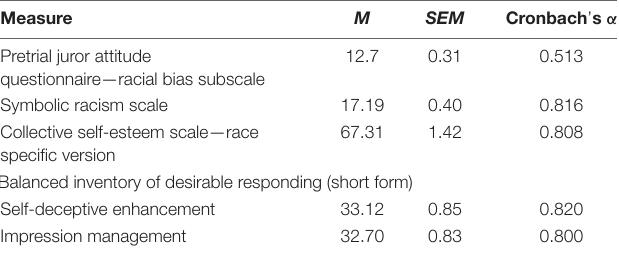
TABLE 3 | Means, standard errors, and reliability for the social attitude scales used in Experiment 2. Measure